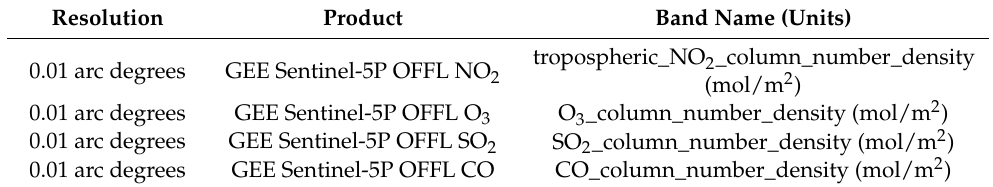
Table 2. TROPOMI sensor Level 3 products from Google Earth Engine (GEE) Cloud Data Archive used in processing the Level 3 GEE